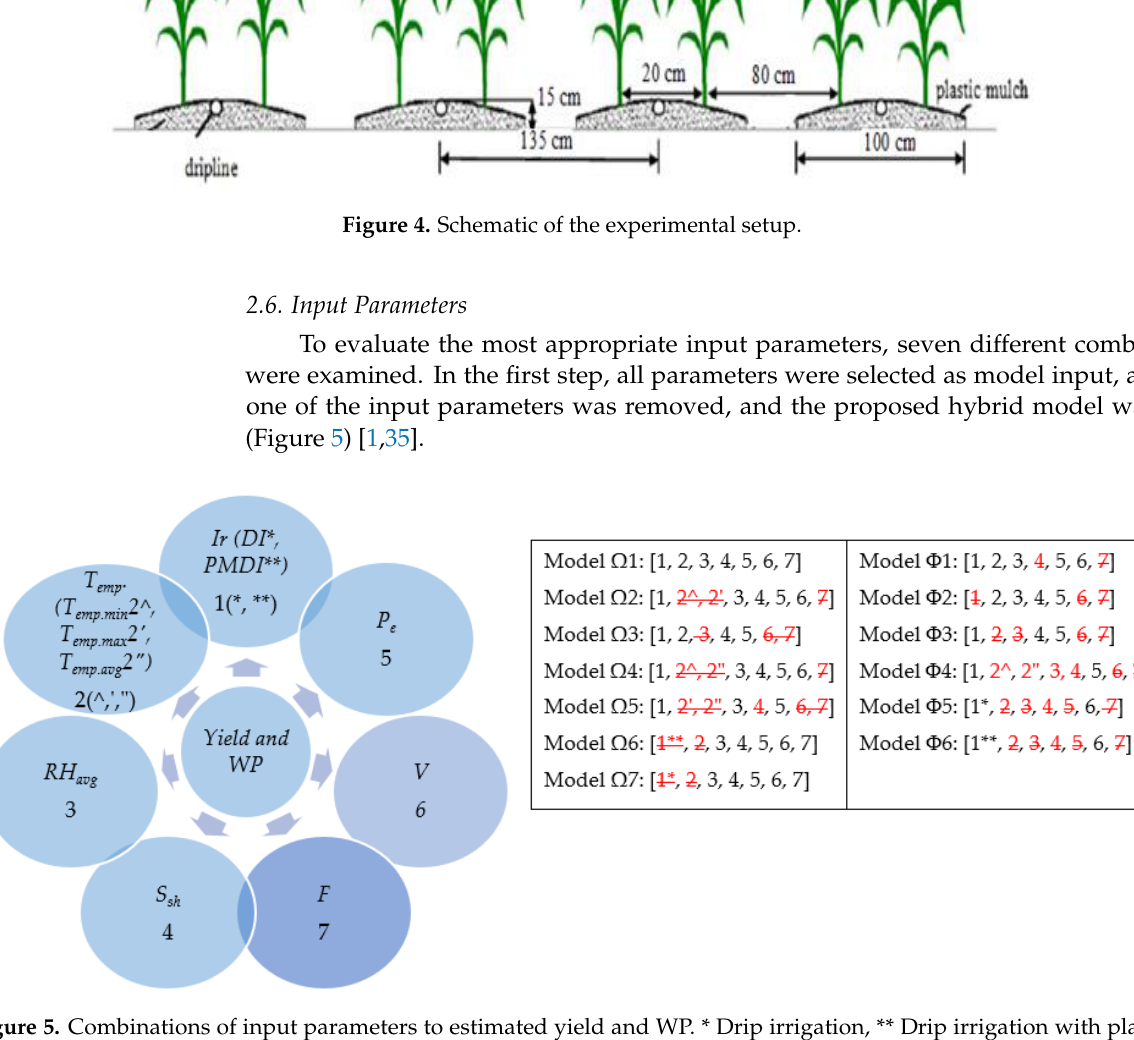
mulch, ˆ Minimum temperature, ’ Maximum temperature, " Average mulch, ^ Minimum temperature, ' Maximum temperature, " Average temperature.